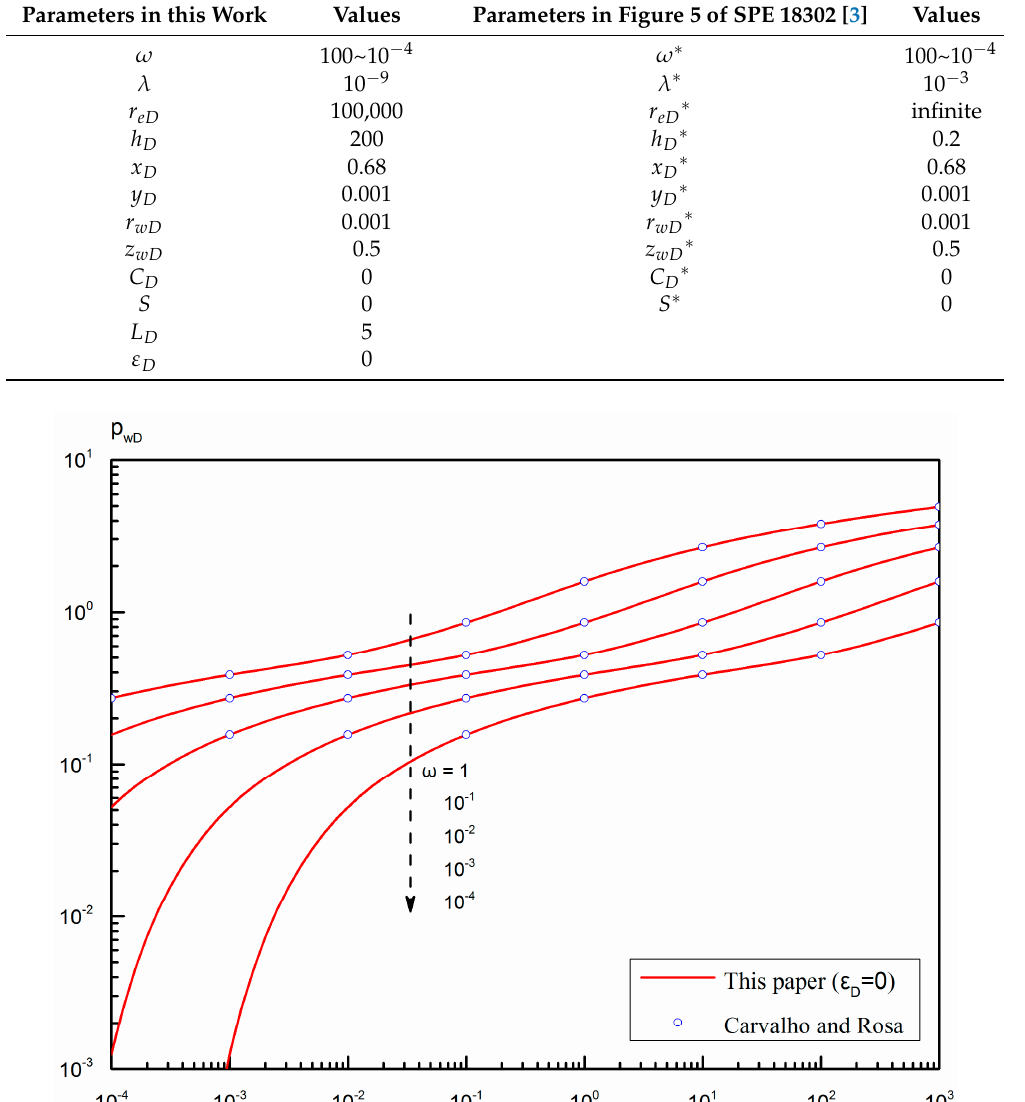
Table 2. Basic data used for verification of the model.